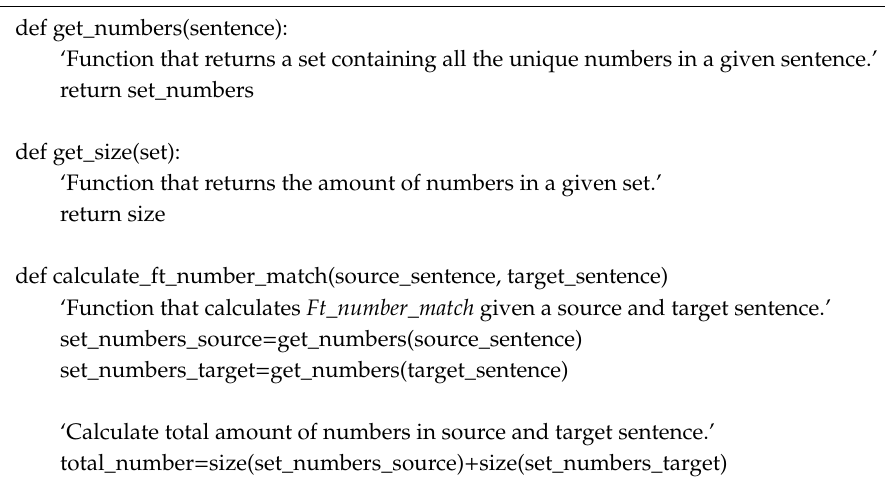
Algorithm A1. Pseudo-code to calculate the feature Ft_number_match.